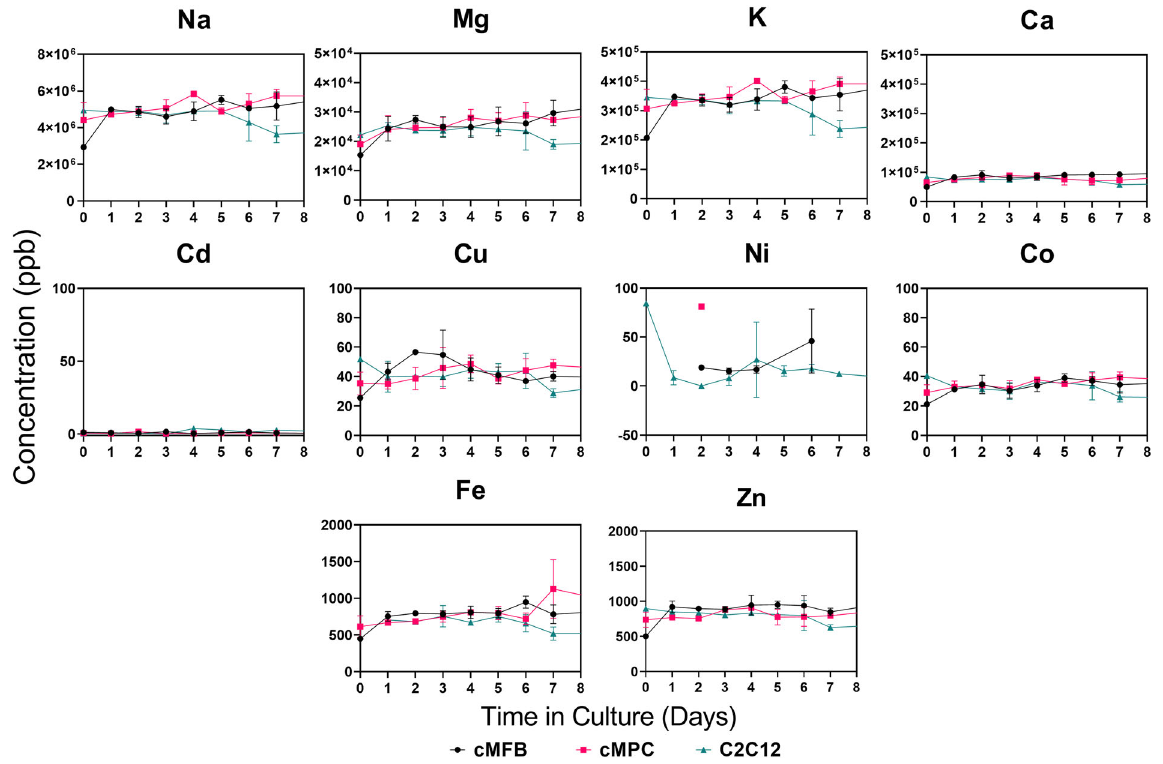
Fig. 4 Minerals. Elemental analysis of spent media from cultures of three cultivated meat-relevant cell types, using inductively coupled plasma-mass spectrometry. Data points represent the mean of three biological replicates ± standard deviation. The y -axis scales vary widely between the graphs, so the fi gure does not directly indicate relative abundances of the different elements in the spent media samples. Several other elements were targeted for analysis but their concentrations in the samples were too low for detection. cMFB primary embryonic chicken muscle fi broblasts. cMPC primary embryonic chicken muscle precursor cells. C2C12 murine myoblast-like cell